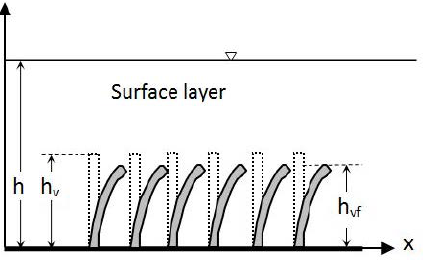
Figure 7. Side view of submerged flexible vegetation.